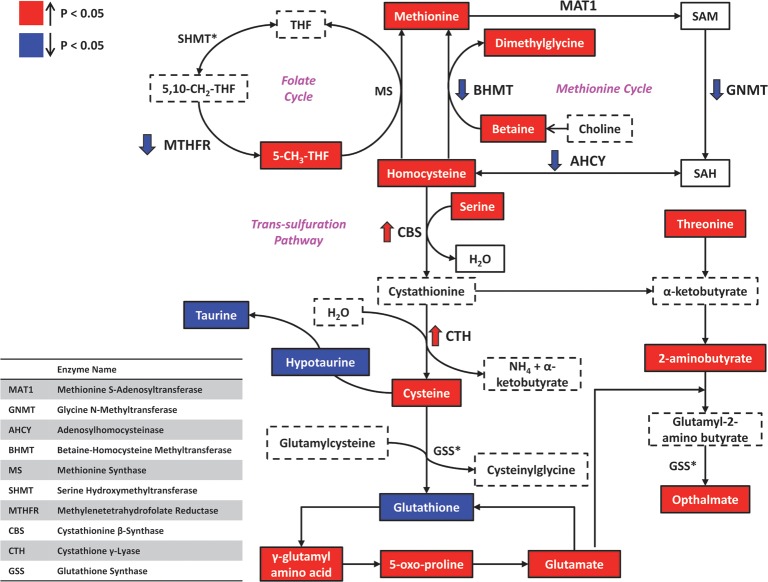
The effect of dietary MR on levels of key molecules and metabolites in hepatic sulfur amino acid metabolism.The changes in expression levels of key molecules in methionine, cysteine and glutathione metabolism are shown. Experimentally measured metabolites are shown as solid boxes, and experimentally measured genes are shown in bold. Dashed boxes refer to metabolites not measured. Upregulated metabolites are colored in red and downregulated metabolites are colored in deep blue (p < 0.05).